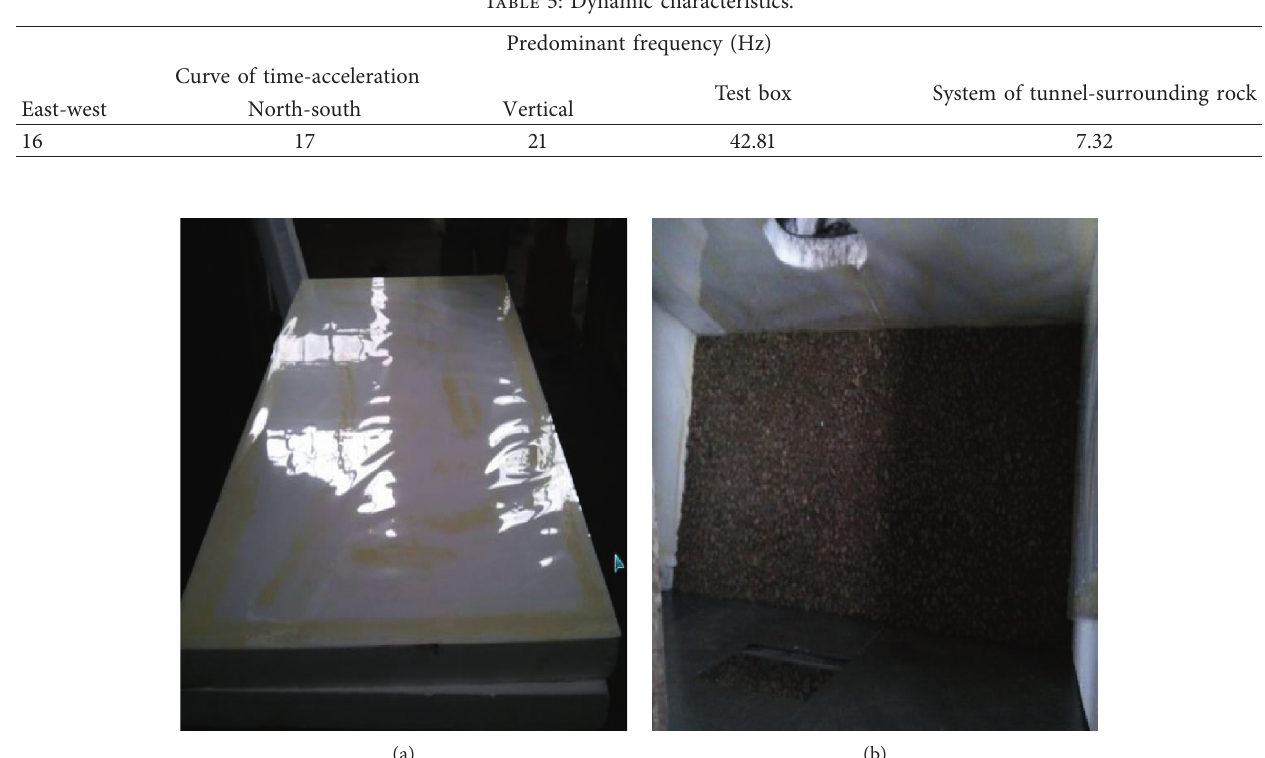
Figure 7: Conditions of boundary. (a) Polystyrene foam board of side wall. (b) Gravel of bottom.